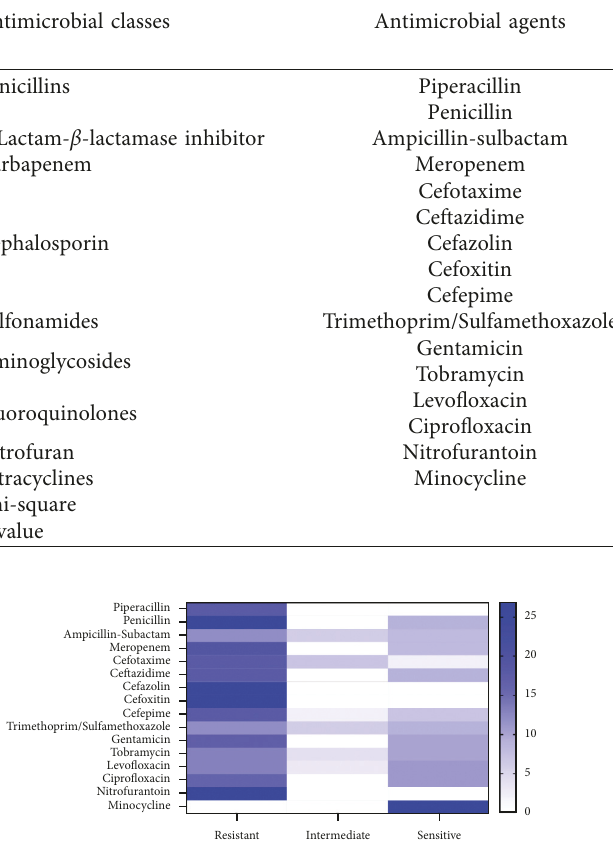
Table 4: Susceptibility pattern of A. baumannii to different antimicrobial agents. Antimicrobial classes